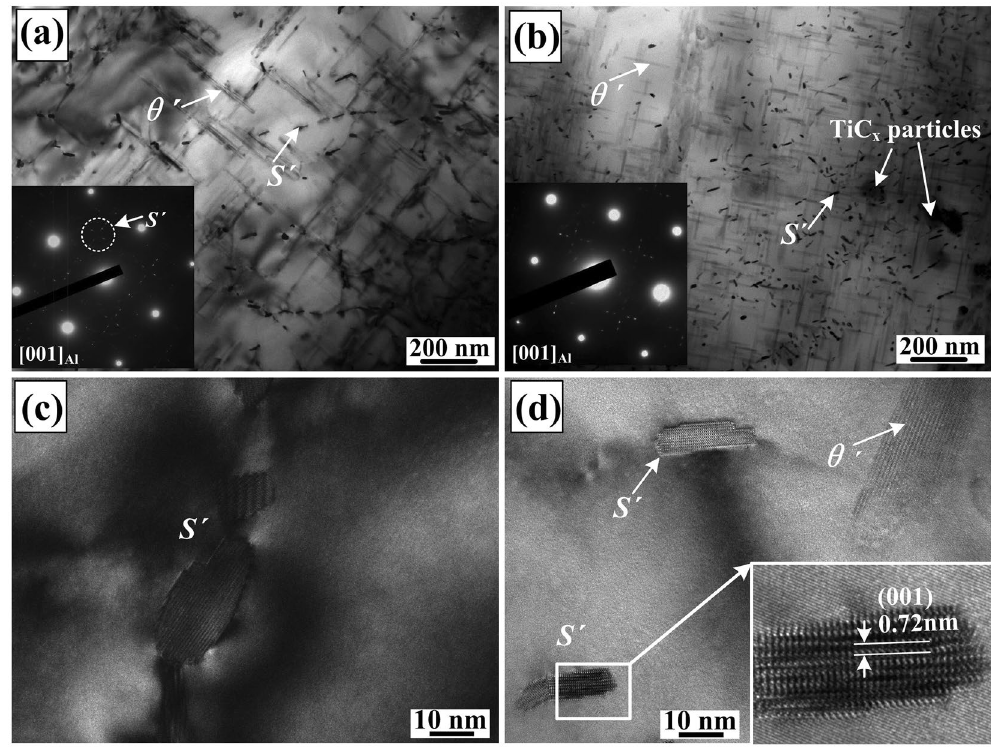
Figure 2. TEM micrographs of θ ′ and S ′ precipitates in ( a ) Al-Cu-Mg alloy and ( b ) nano-sized TiC x /Al-Cu-Mg composites, insert: SAED pattern of α -Al from [001] α -Al direction; HREM images of S ′ precipitates for ( c ) Al- Cu-Mg alloy and ( d ) the